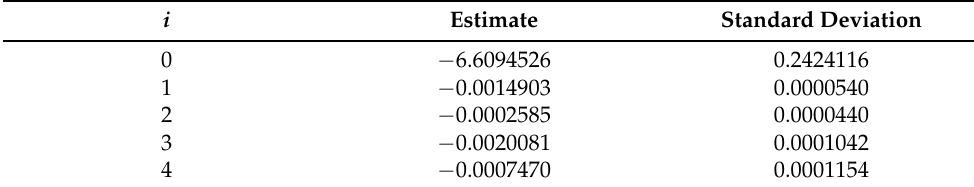
Table 3. Estimates of β i and corresponding errors.